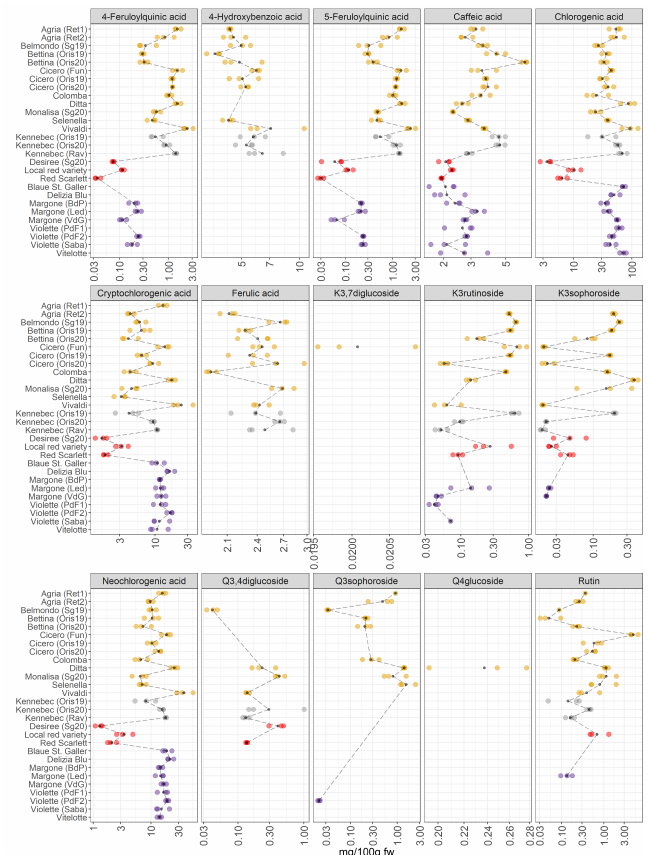
Figure 4. Polyphenolic compounds in 28 potato varieties organized in four groups (yellow-, white-, red-skinned, and purple-fleshed); three biological replicates for each sample were analyzed. The black points represented the averages for each analyte calculated on three biological replicates. The black long dash lines showed the concentration trends amongst all the potato groups. The concentrations were transformed in a log-10-scale. K = Kaempferol, Q = Quercetin, fw = fresh weight. For more detailed information about potato varieties see Table